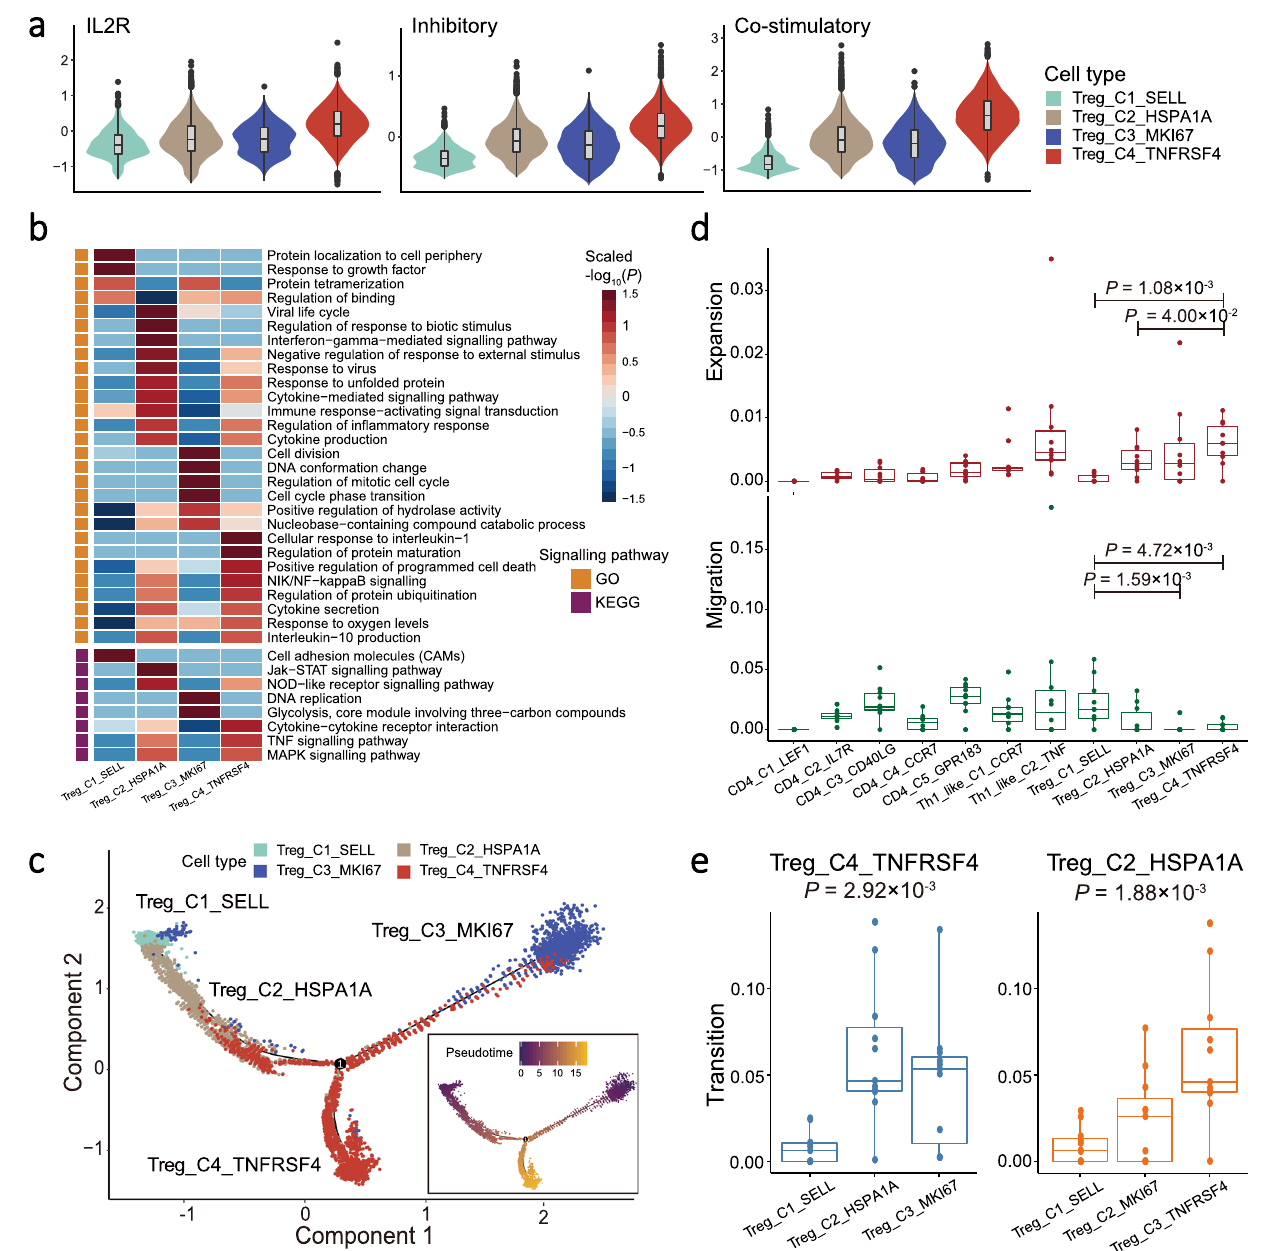
Fig. 3 Expression pro fi le and development of Treg cells. a Violin plots showed the IL2R (left panel), inhibitory (middle panel), and co-stimulatory (right panel) scores for each Treg cell cluster ( n = 11,631). Box plots inside the violins indicated the quartiles of corresponding score levels. Endpoints depict minimum and maximum values; centre lines denote median values; whiskers denote 1.5× the interquartile range; black dots denote each cell. Violin plots are coloured according to cell types, and signature scores are indicated at the y -axis. b Heatmap showed the selected signalling pathways (rows) that were signi fi cantly enriched in GO and KEGG analyses for each Treg cell cluster (columns). Filled colours from blue to red represent scaled expression levels (normalised − log 10 P values) from low to high. P values were calculated by one-sided hypergeometric test and adjusted for multiple comparisons. Orange and purple squares on the left column represent the results derived from GO and KEGG signalling pathways analysis, respectively. c Pseudotime trajectory analysis of Treg cells (Treg_C1, Treg_C2, Treg_C3, and Treg_C4; n = 11,631) with high variable genes. Each dot represents one single cell, coloured according to its cluster label. The inlet plot showed each cell with a pseudotime score from dark blue to yellow, indicating early and terminal states, respectively. d Box plots showed the expansion- (top panel) and migration-index (bottom panel) scores of each CD4 + T cell cluster ( n = 10). Comparison was made using two-sided Wilcoxon test. Cell clusters are indicated at the x -axis, and the y -axis shows the expansion- or migration-index at the top or bottom panel, respectively. Endpoints depict minimum and maximum values; centre lines denote median values; whiskers denote 1.5× the interquartile range; coloured dots denote each patient. e Box plots showed the transition-index scores of Treg_C4_TNFRSF4 (left panel) and Treg_C2_HSPA1A (right panel) with other Treg cells ( n = 10). Comparison was made using two-sided Kruskal-Wallis test. Cell clusters and the transition-index scores are indicated at the x - and y -axis, respectively. Endpoints depict minimum and maximum values; centre lines denote median values; whiskers denote 1.5× the interquartile range; coloured dots denote each